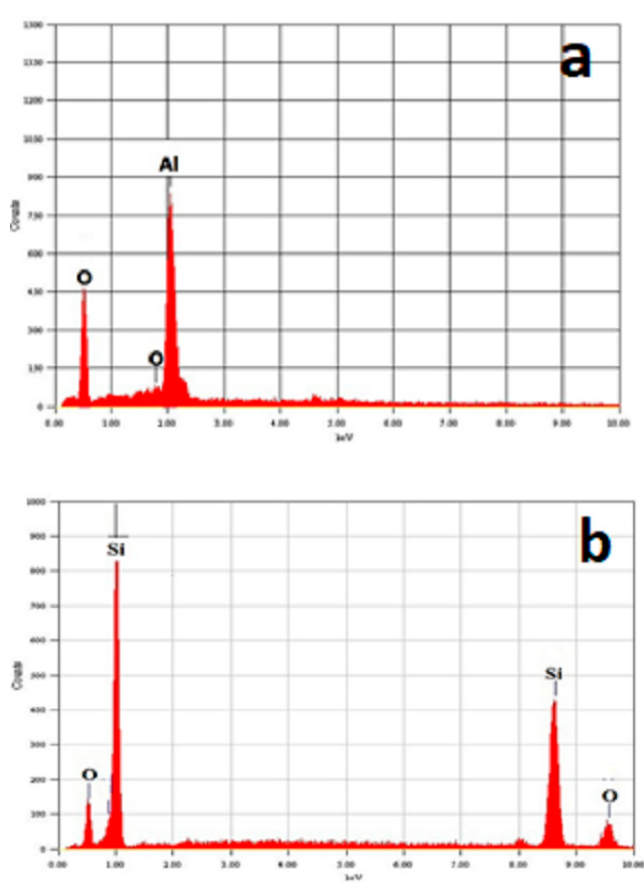
Figure A5. EDS image of ( a ) Al 2 O 3 NPs and ( b ) SiO 2 NPs. SEM analysis along with energy-dispersive X-ray spectroscopy (EDS) provides infor- mation on the morphology, particle size and elemental composition of Ag loaded Al 2 O 3 (Figure A6a–d). Figure A6a–c presents the SEM images which reveal the presence of randomly distributed spherical particles in the form of larger agglomerates with particle sizes